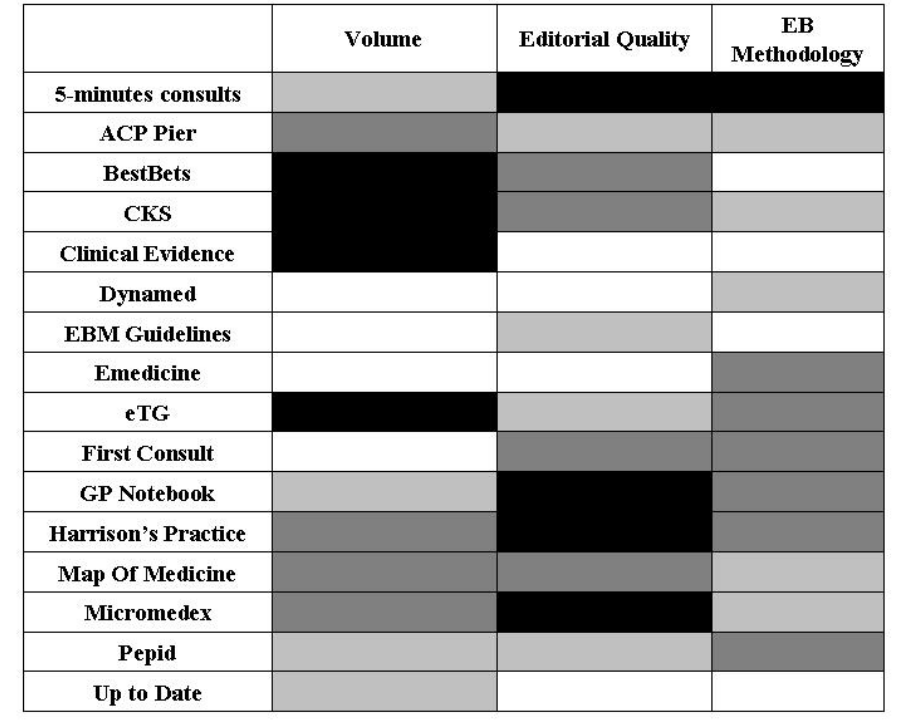
Figure 4. EBP point-of-care summary provider ranking for volume, editorial quality and evidence-based methodology. (Black represents the bottom quartile; dark grey represents the low intermediate quartile; light grey represent the high intermediate quartile; and white represents the top